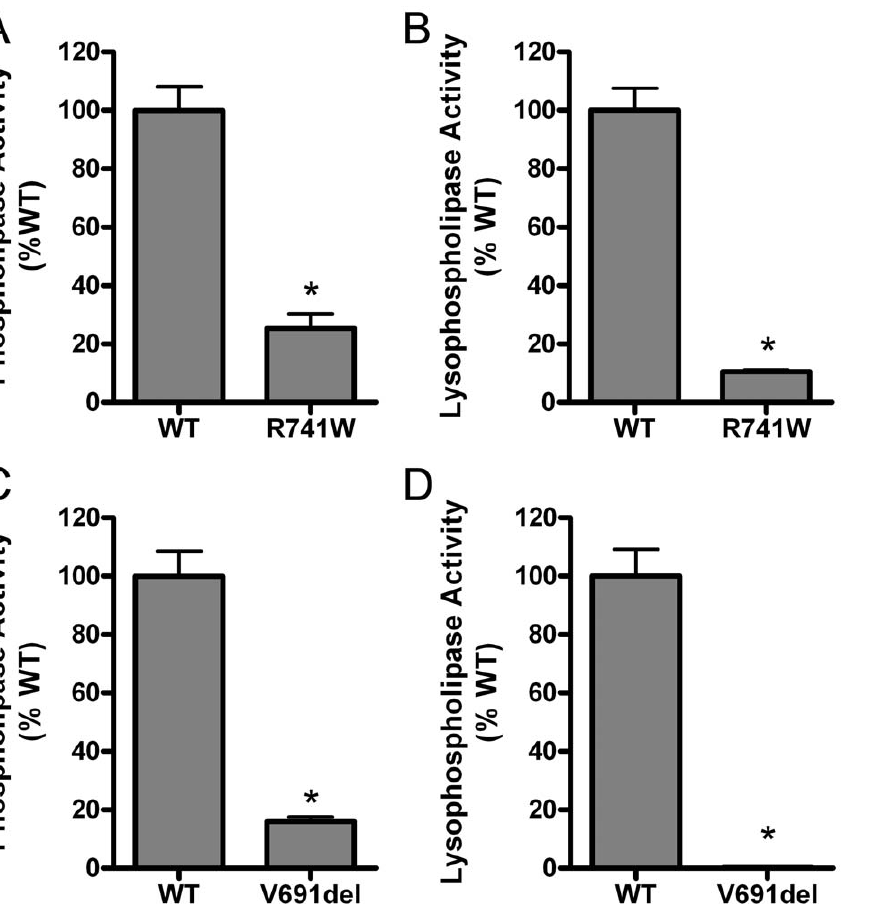
Figure 4. The effects of additional mutations illustrate the significance of genotype distinctions between INAD/NBIA and dystonia- parkinsonism. The INAD/NBIA-associated R741W mutation (A, B) was investigated because mutation of the same residue to a glutamine (R741Q) has been identified in dystonia-parkinsonism. The V691del mutation was examined given its association with an R632W mutation in an INAD patient with compound heterozygous mutations (C, D), in contrast to homozygous R632W mutations associated with dystonia-parkinsonism. Phospholipase (A,C) and lysophospholipase (B,D) activities are shown as percent of WT activity measured when equal concentrations of protein were added to assays measuring release of fatty acids from radiolabeled substrate. Bars indicate mean plus standard deviation (n=3) from representative experiments. Asterisks indicate mean activities that were significantly different from WT (p , 0.05, unpaired t-test). Similar results were obtained in at least two experiments with independent transfection and purification of recombinant